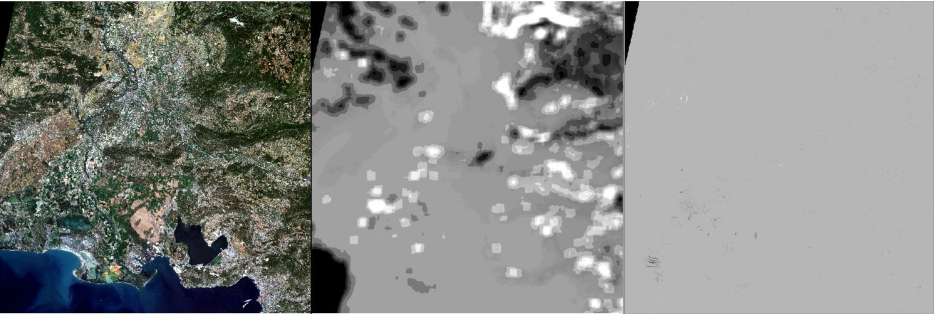
Figure 7. L1C RGB ( left ), AOT (@ 550 nm) map Thuillier 2003 ( middle ) and AOT relative difference map between Thuillier and TSIS product ( right